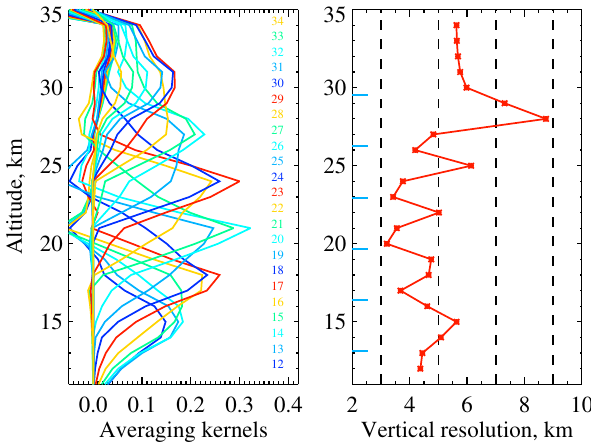
Fig. 6. Averaging kernels (left panel) and the vertical resolution (right panel) typical for the IUP Bremen retrieval. The colored num- bers on the right-hand side of the averaging kernel plot denote the altitudes which the averaging kernels are calculated for. The thick blue lines in the left-hand side of the vertical resolution plot depict positions of the measurement tangent